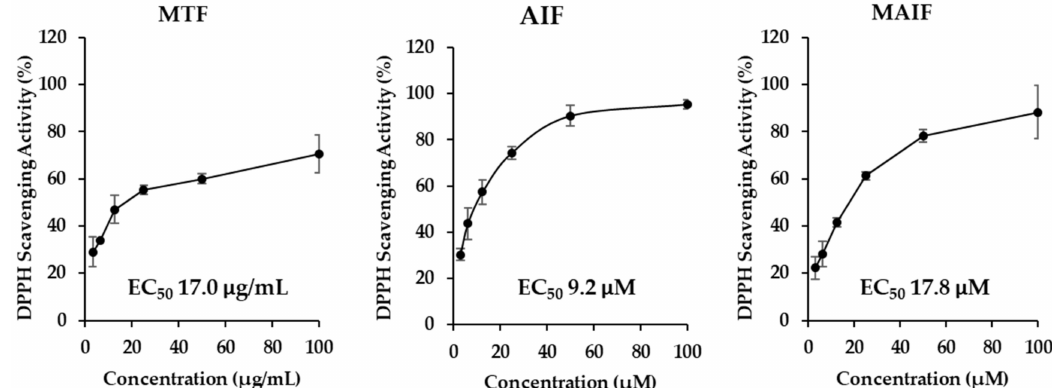
Figure 2. DPPH (2,2-diphenyl-1-picrylhydrazyl) radical scavenging activity by M. tricuspidata fruit extract (MTF), alpin- umisoflavone (AIF), and 4 (cid:48) - O -methyl alpinumisoflavone (MAIF). Each sample was added to DPPH in 96-well plate and mixed. After incubation for 1 h in the dark, the absorbance was measured at 520 nm wavelength using a microplate reader. (EC 50 : Half maximal effective